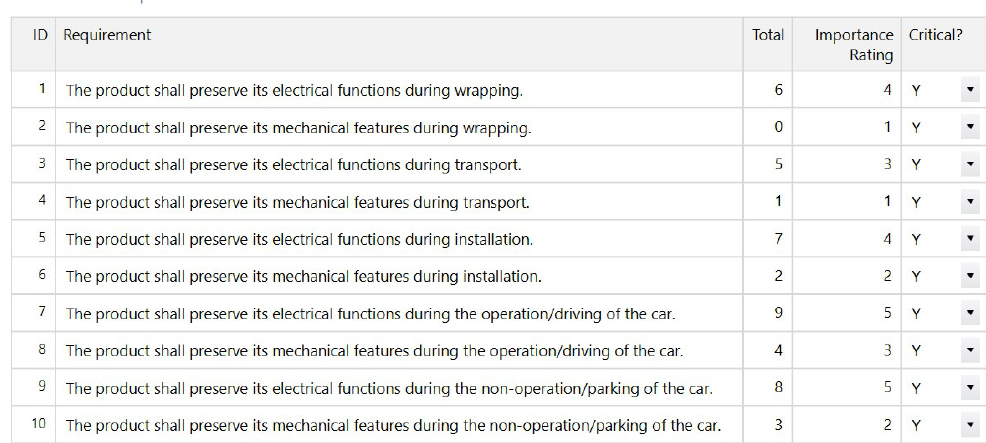
Figure 3. The formulation of requirements regarding robustness. It can be seen that robustness means that the product preserves its functions and features during different conditions.